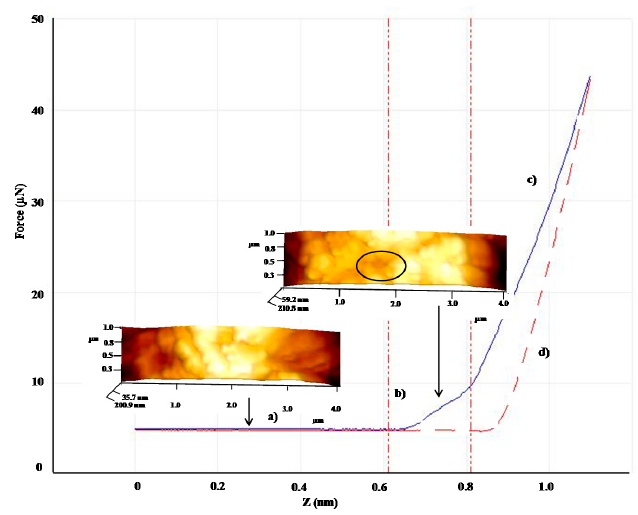
Figure 6. Mechanical testing of the elastic-plastic region by AFM of the MPCM composed by PS:tetracosane (1:3) microcapsule at 60 °C: ( a ) no contact, continuous line; ( b ) plastic penetration; ( c ) deformation of the sample; and ( d ) retraction of the AFM probe, discontinuous line.